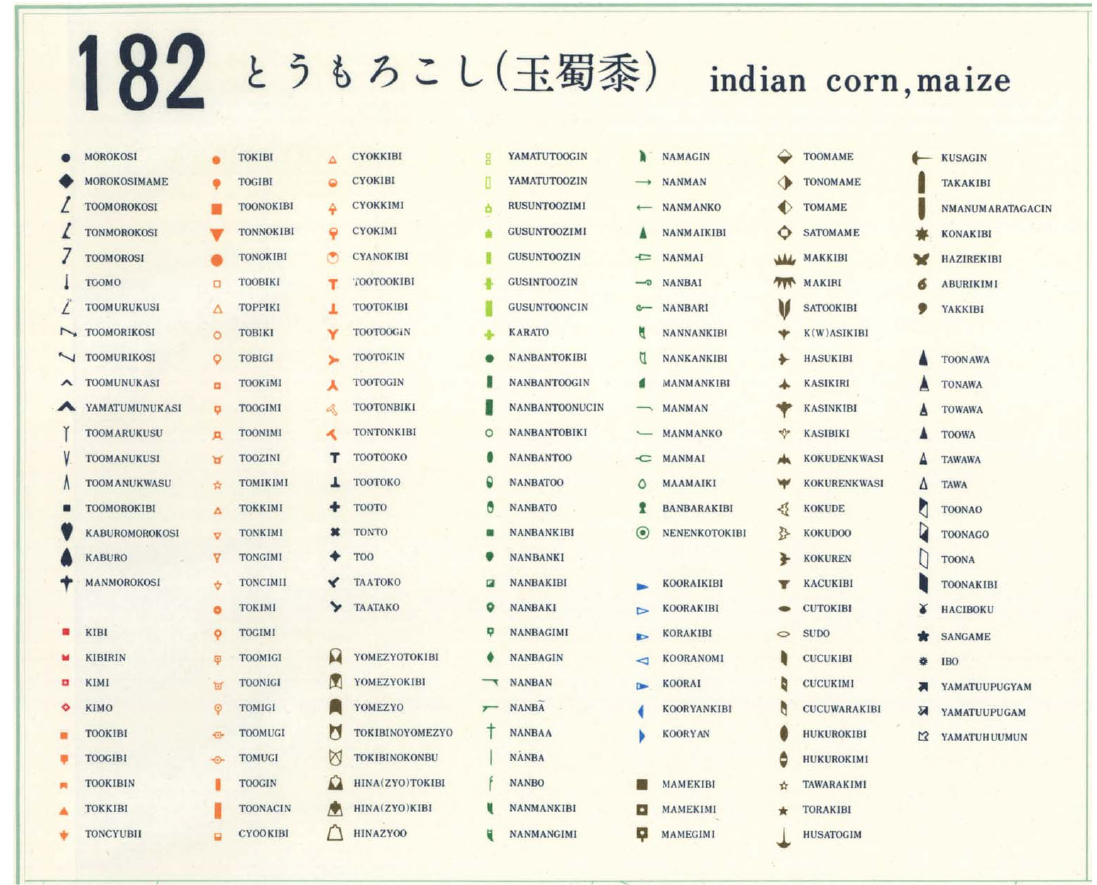
Figure 3. The legend of the example LAJ map Nr. 182 in Figure 2. The variant categories in our research were set up based on the groupings visible in such